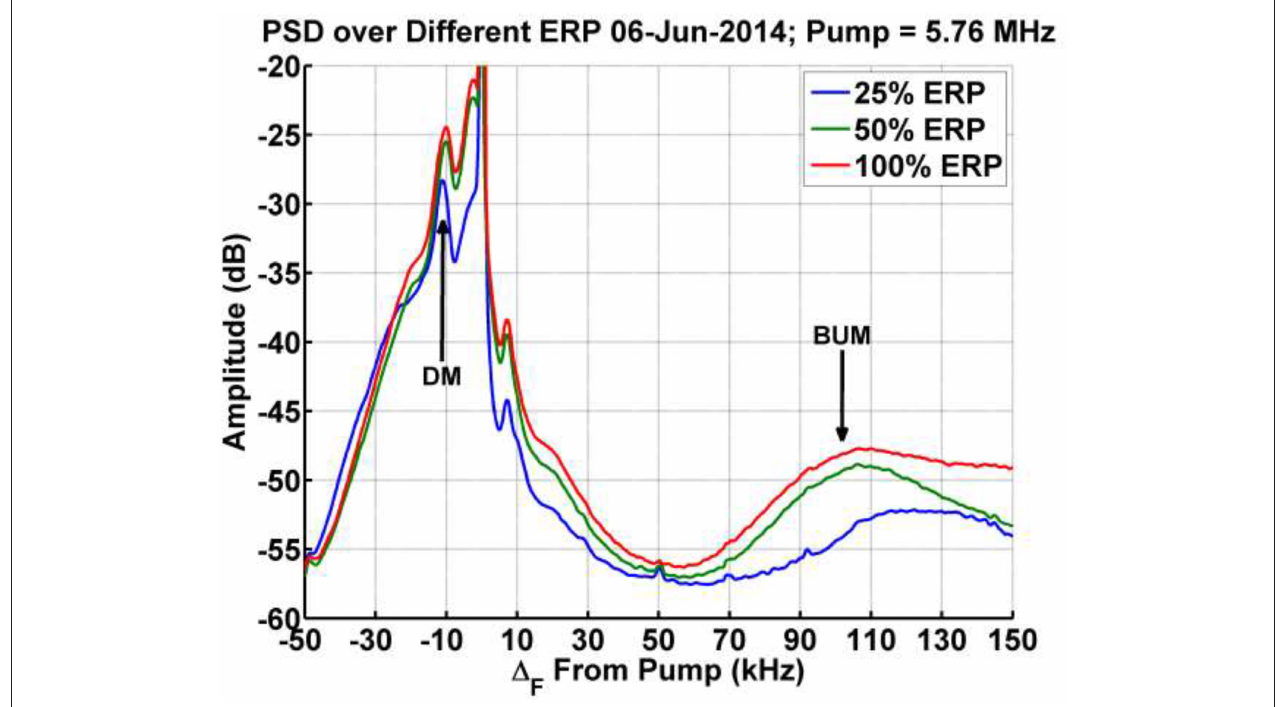
FIGURE 4 | Power spectral densities (PSD) of broadband SEE vs. 1 F . The traces are averaged over 10s of the heating time. Variations of the effective radiated power (ERP) are shown in the figure by the color traces. The heating frequency is shown by the highest peak at 1 F = 0, while the down shifted maximum (DM) and the broad upshifted maximum (BUM) are on the left and right side, respectively [adapted from ( Najmi et al., 2015)].